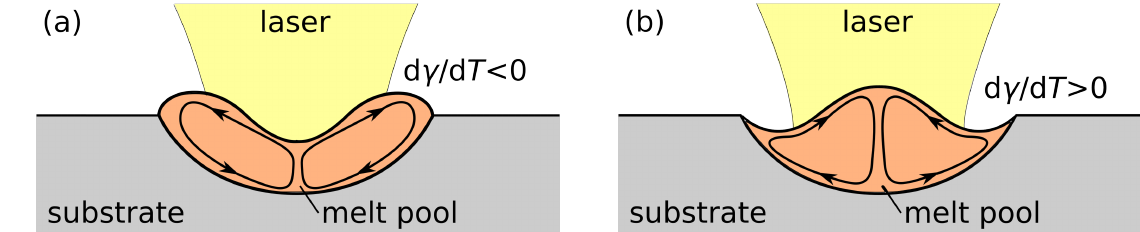
Figure 1. Surface evolution during laser processing due to temperature gradients and thermocapillary flow for ( a ) negative and ( b ) positive temperature coefficients of surface tension d γ / d T , outlines adopted from